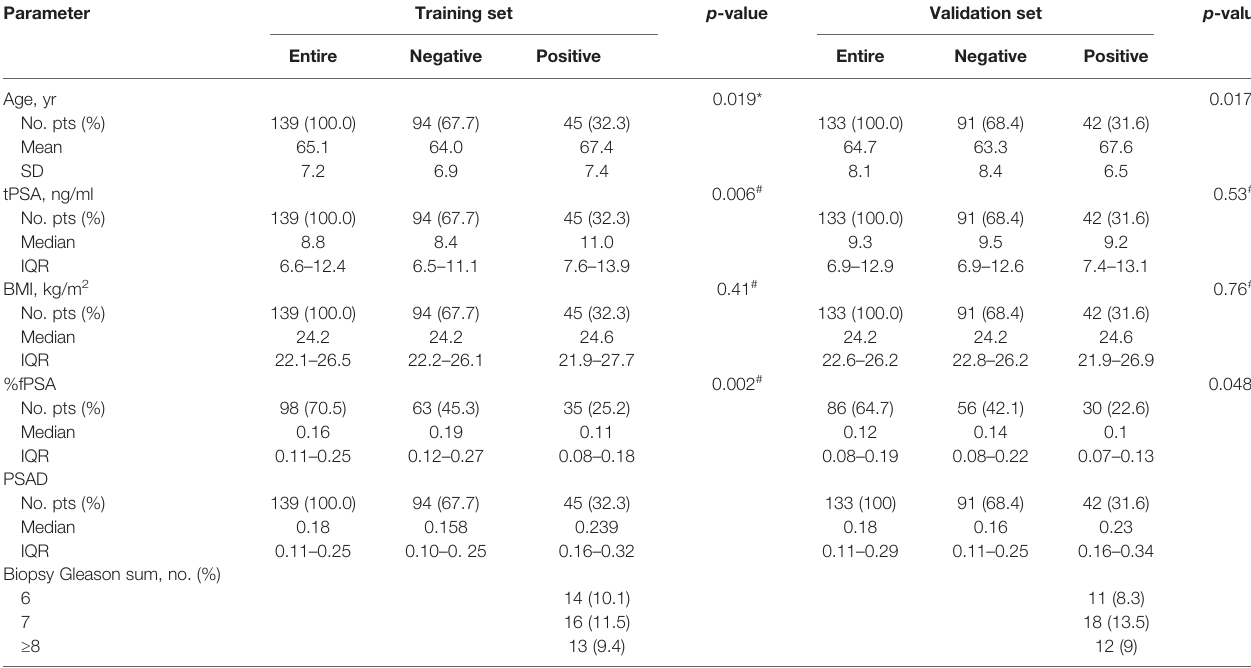
TABLE 1 | Demographics and clinical characteristics of participants.